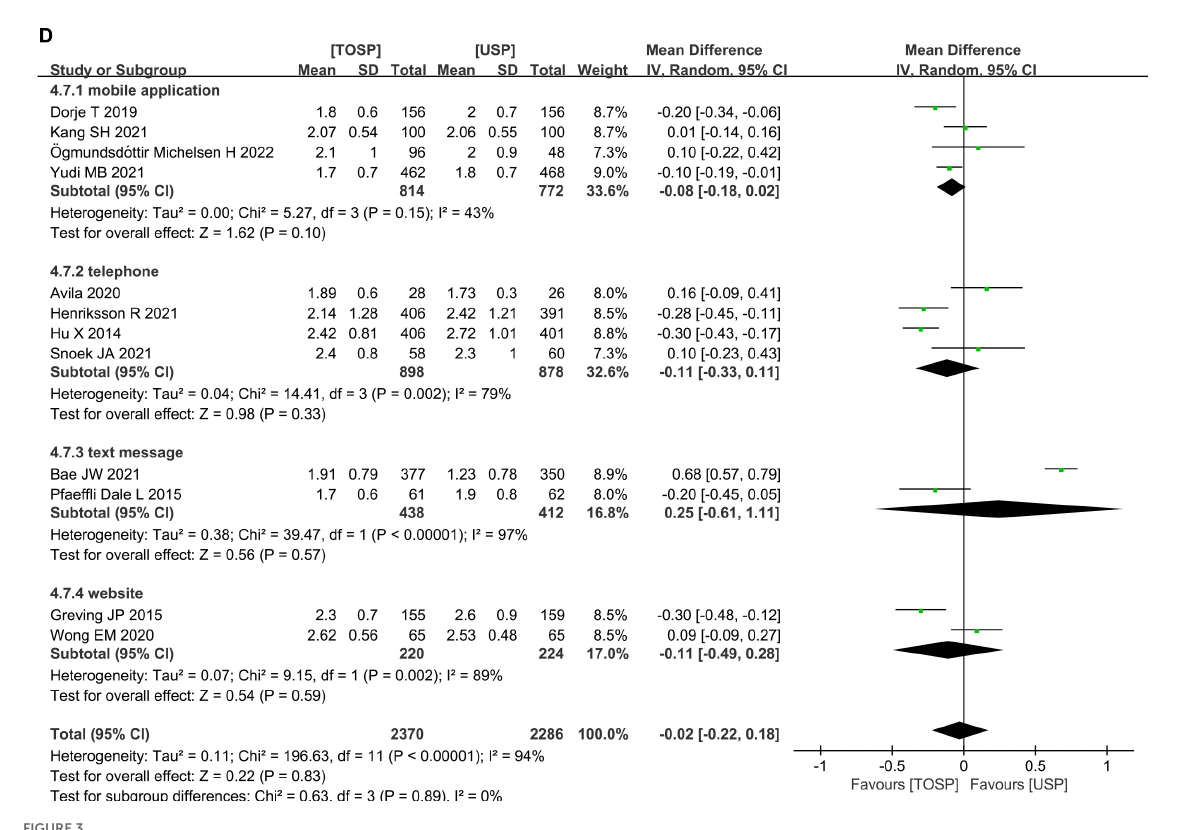
FIGURE3 Forest plots of the effects of telemedicine on risk factors— (A) BMI; (B) DBP; (C) SBP; (D) LDL-C; TOSP, telemedicine of secondary prevention; USP, usual secondary